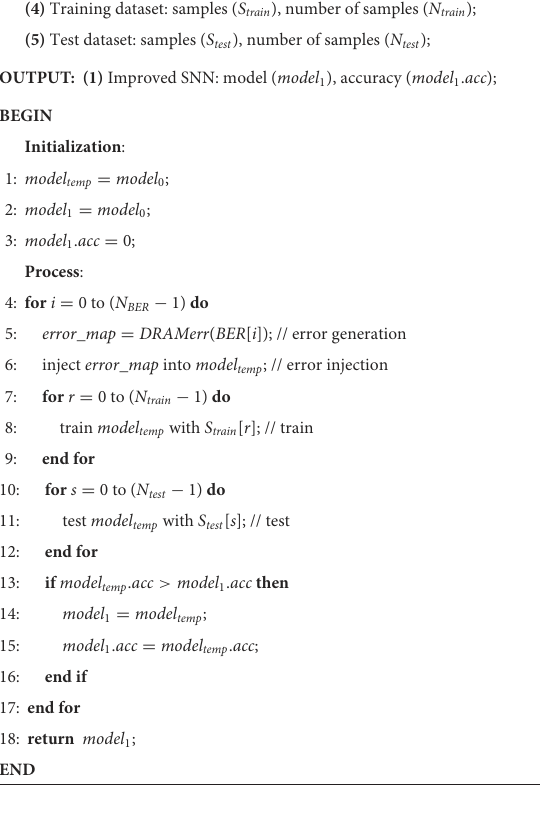
Algorithm 2 The proposed FAT